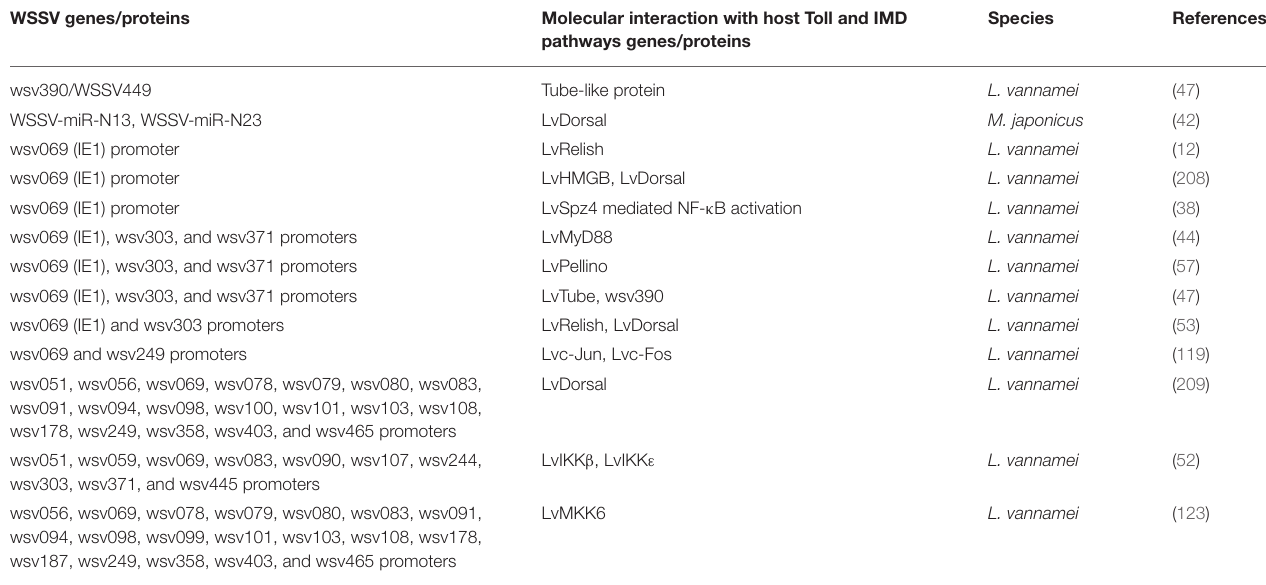
TABLE 4 | WSSV proteins/genes related to host (shrimps) Toll and IMD pathways—proteins/genes. WSSV